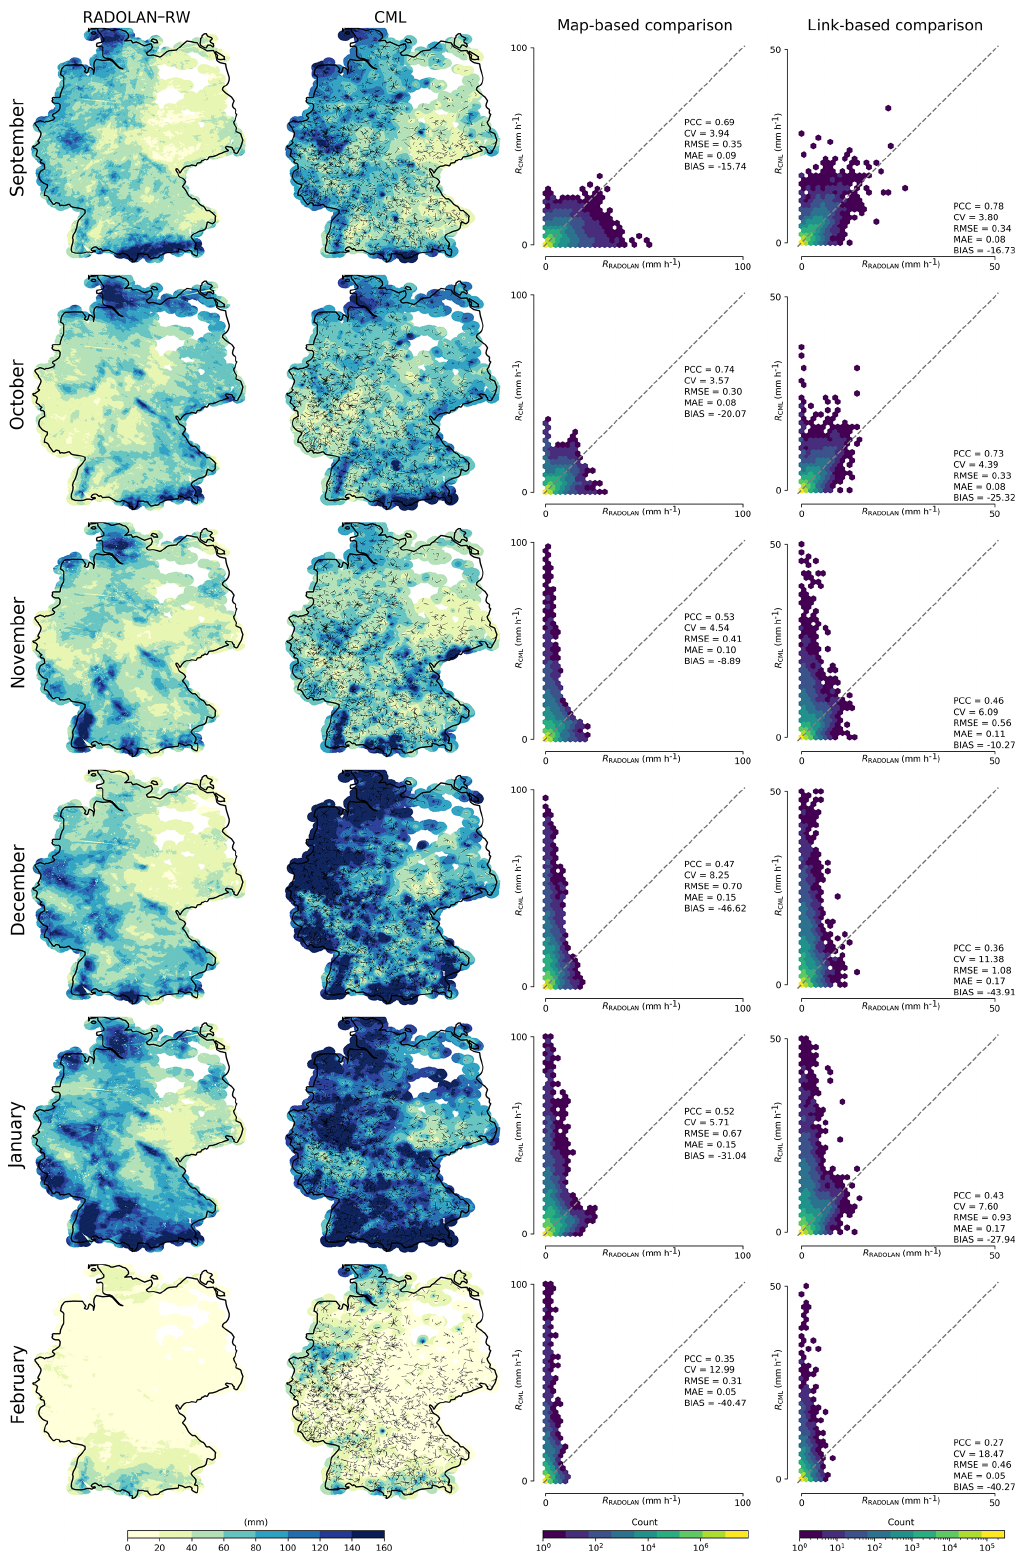
Figure 8. Monthly aggregations of hourly rainfall maps from CMLs compared to RADOLAN-RW from September 2017 to February 2018. For each month, two scatter density plots are shown: one for pixel-by-pixel comparison of the hourly maps (map-based comparison), and one for the comparison of the hourly path-averaged rainfall along the individual CMLs (link-based